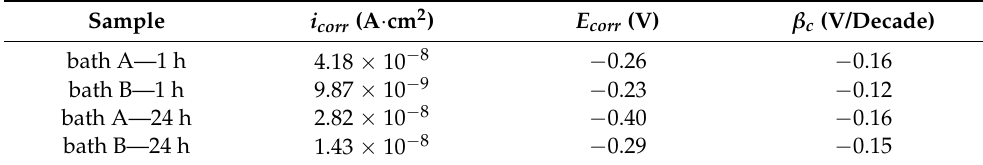
Table 2. Polarization resistance of the PEO-treated Cp-Ti in two different aluminate concentrations: low concentration (bath A) and high concentration (bath B). The polarization tests were performed in 3.5 wt.% NaCl solution measured from − 0.25 to 0.4 V vs. open circuit potential.